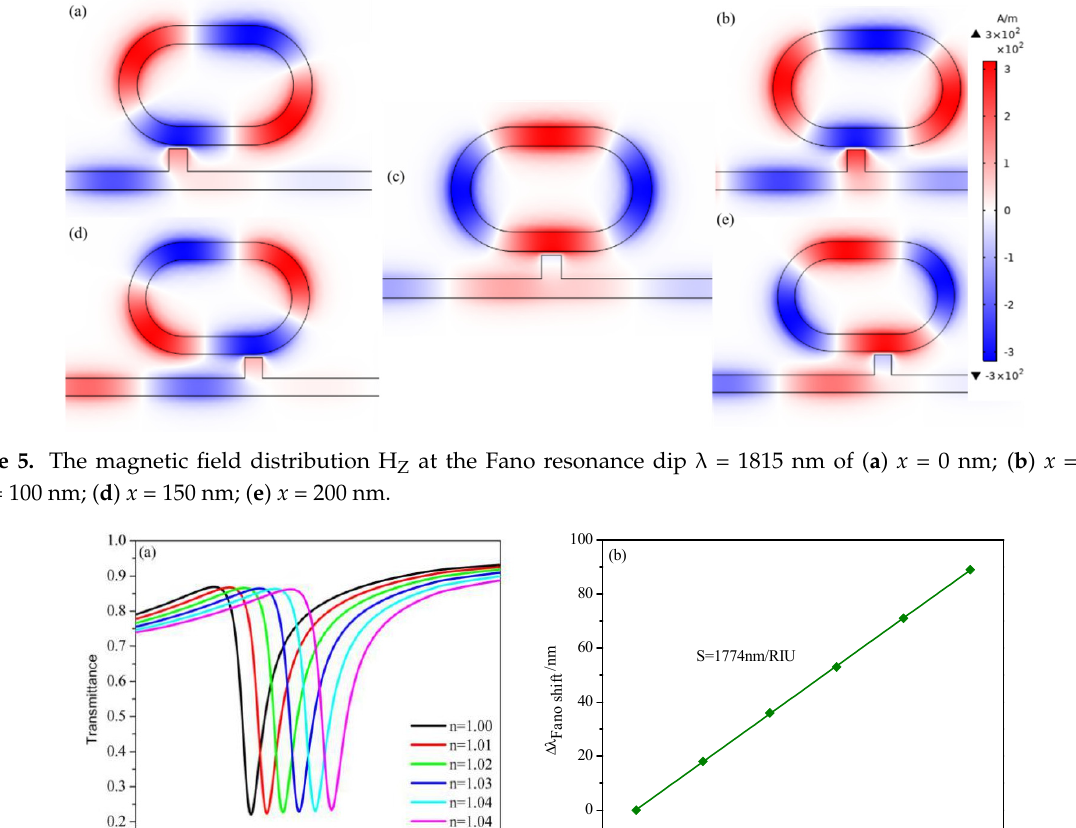
Figure 5. The magnetic field distribution H Z at the Fano resonance dip λ = 1815 nm of ( a ) x = 0 nm; ( b ) x = 50nm; ( c ) x = 100 nm; ( d ) x = 150 nm; ( e ) x = 200 nm.